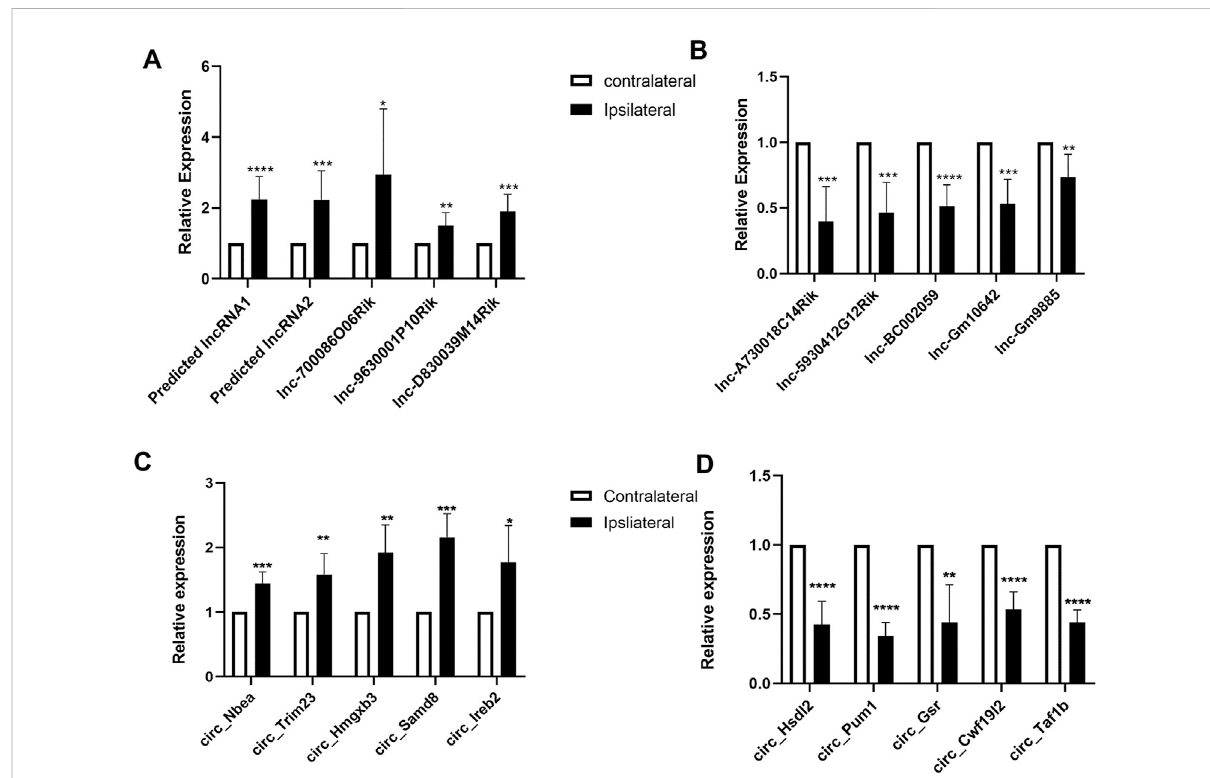
FIGURE 5 Validations of differentially expressed long noncoding RNAs (lncRNAs) and mRNAs in the TG of temporomandibular joint disorder (TMD) mice. (A,B) levelsoflncRNAsintheTGonday3afterTMD.n=10mice/group.* p < 0.05,** p < 0.01,and*** p <